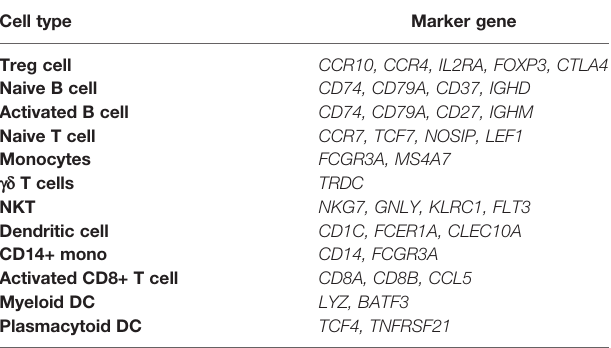
TABLE 2 | Marker genes used for cell type annotation in the current study. Cell type